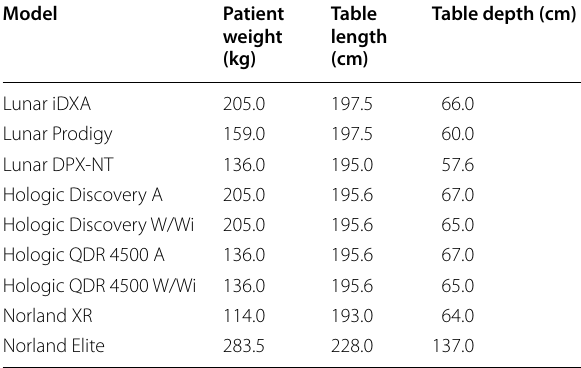
Table 7 Maximum patient weight and table height and depth for different models of DXA systems (adapted from Reference